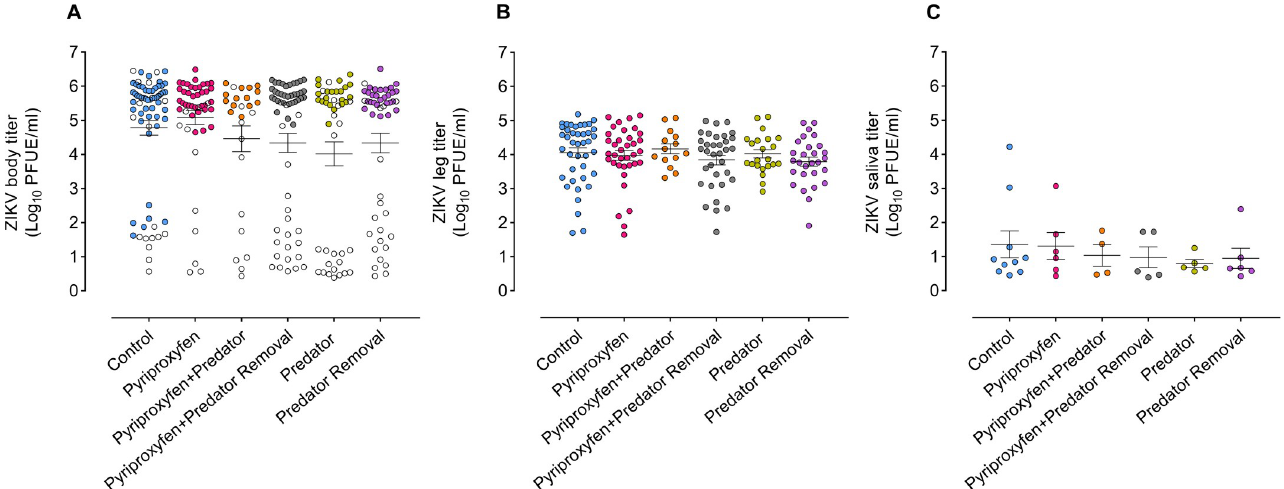
Fig 5. Effects of juvenile treatments on titrations of ZIKV in Ae . aegypti tissues. (A) Viral body, (B) leg, and (C) saliva titers (plaque forming unit equivalents/ ml) of ZIKV-positive female Ae . aegypti . Horizontal lines indicate the mean of viral titers. Whiskers denote the standard error of the means. Each circle represents the titer for an individual female Ae . aegypti . Open circles in (A) represent the titers for females with non-disseminated infection of ZIKV (i.e., viral infection limited to mosquito midgut), whereas filled circles represent the titers for females with disseminated infection of ZIKV (i.e., viral dissemination from mosquito midgut epithelium). For all treatments, viral body, leg, and saliva titers were estimated at 15 days post-ZIKV infection.